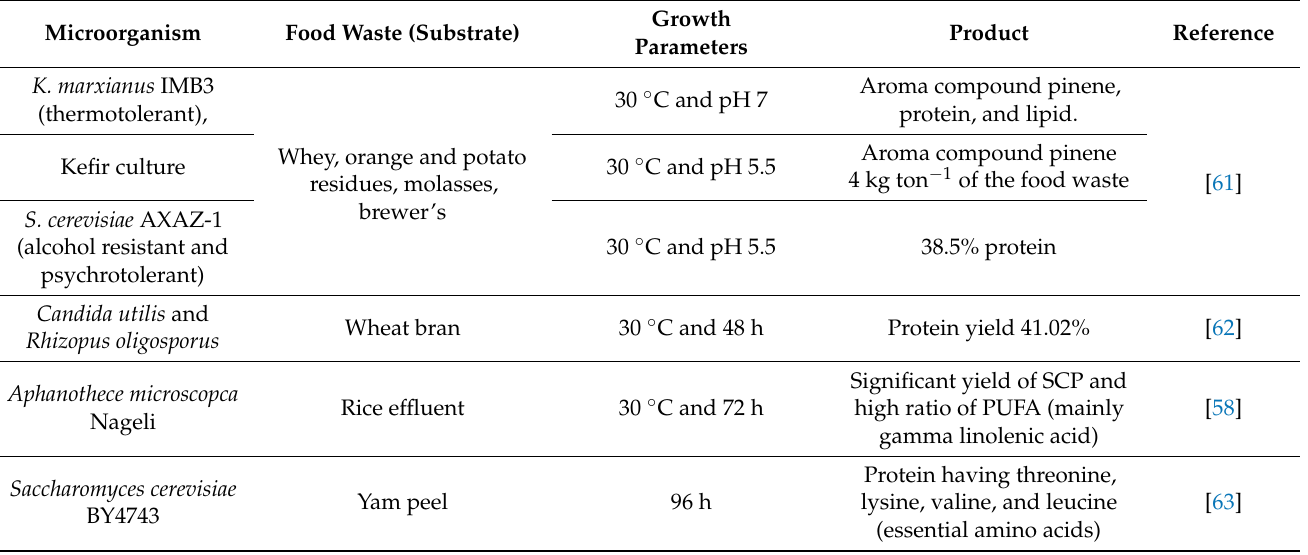
Table 2. Various microorganisms, food waste and growth parameters for producing protein and other